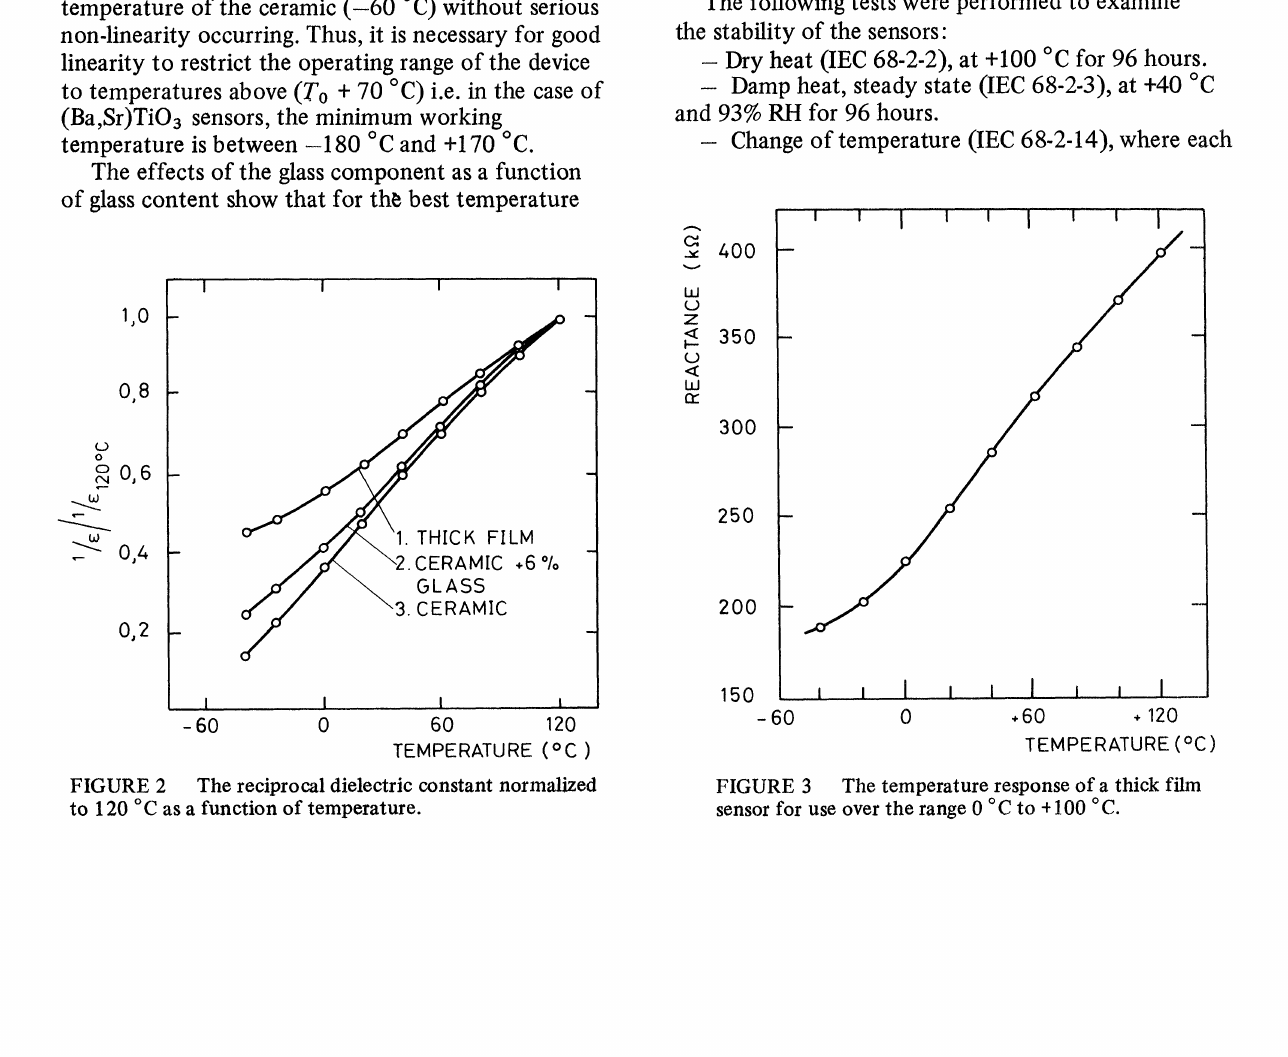
The reciprocal dielectric constant normalized oc to 120 as a function of temperature.